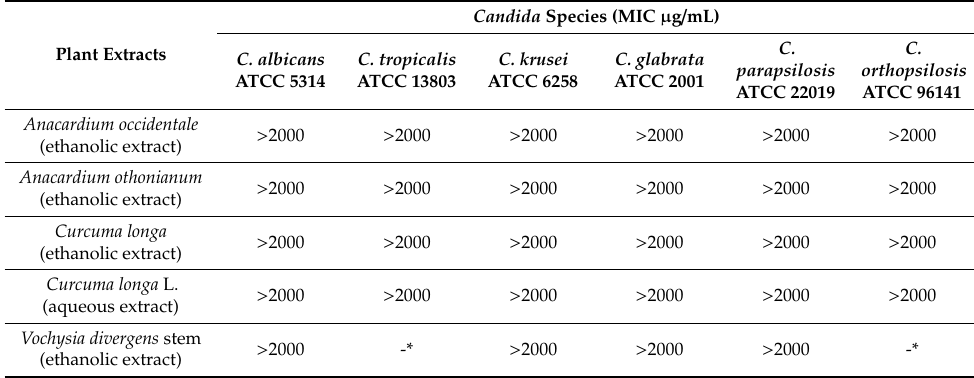
Table 2. Minimal inhibitory concentrations (MIC) of plant extracts against Candida species.